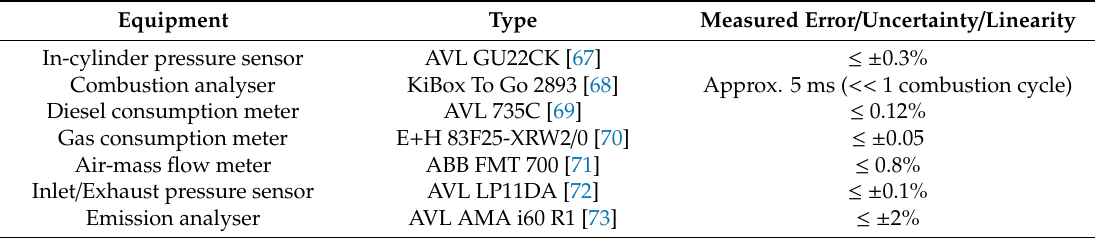
Table 2. Employed sensors specifications.